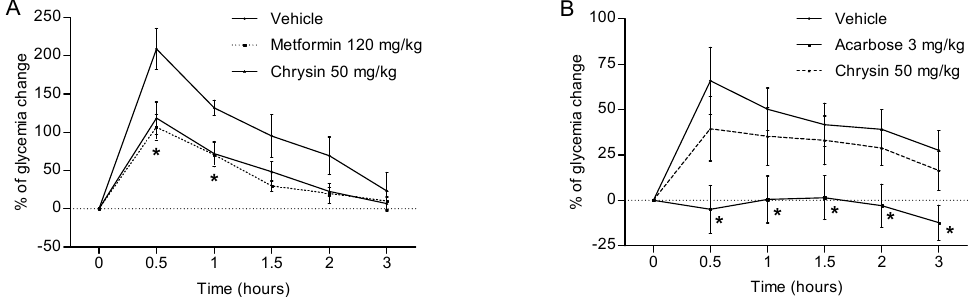
Figure 1. Effect of chrysin (50 mg/kg) on blood glucose levels after single oral administration of 2 g/kg of ( A ) glucose and ( B ) sucrose in athymic nude normoglycaemic mice. Each plot represents the means ± SEM, n = 8; * p < 0.05.